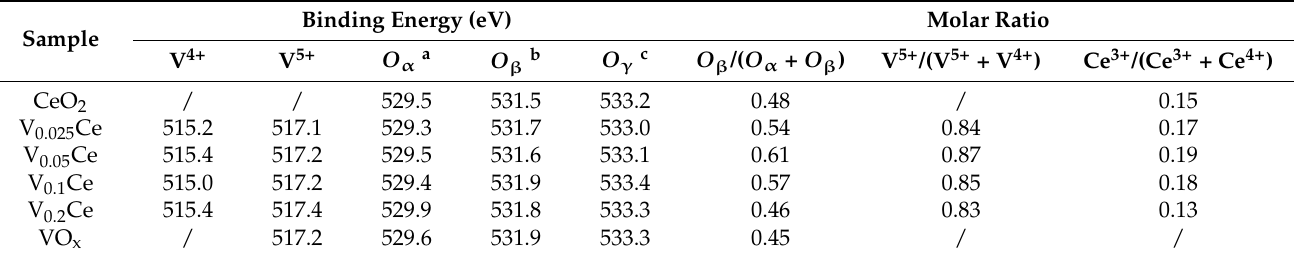
Figure 4. X-ray photoelectron spectroscopy (XPS) spectra of prepared catalysts: ( a ) C 1 s , ( b ) O 1 s , ( c ) V 2 p , and ( d ) Ce 3 d . Table 2. XPS results of prepared